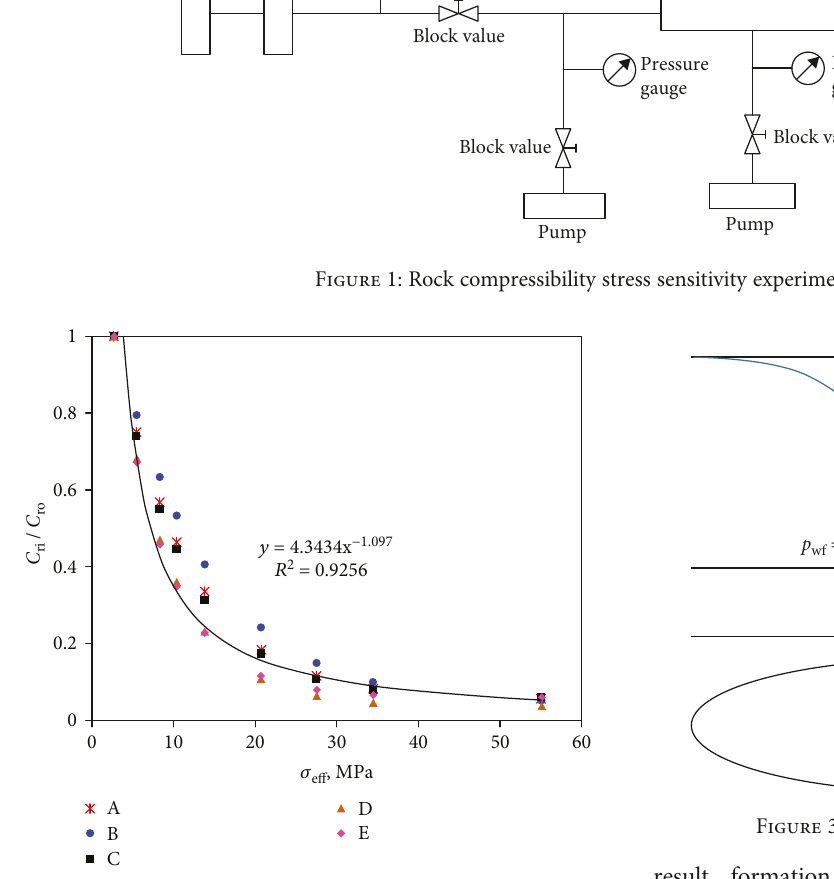
Figure 2: Rock compressibility stress sensitivity experimental results.